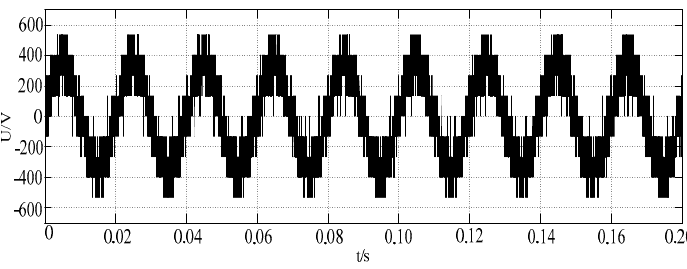
Figure 11. Output voltage of phase A.